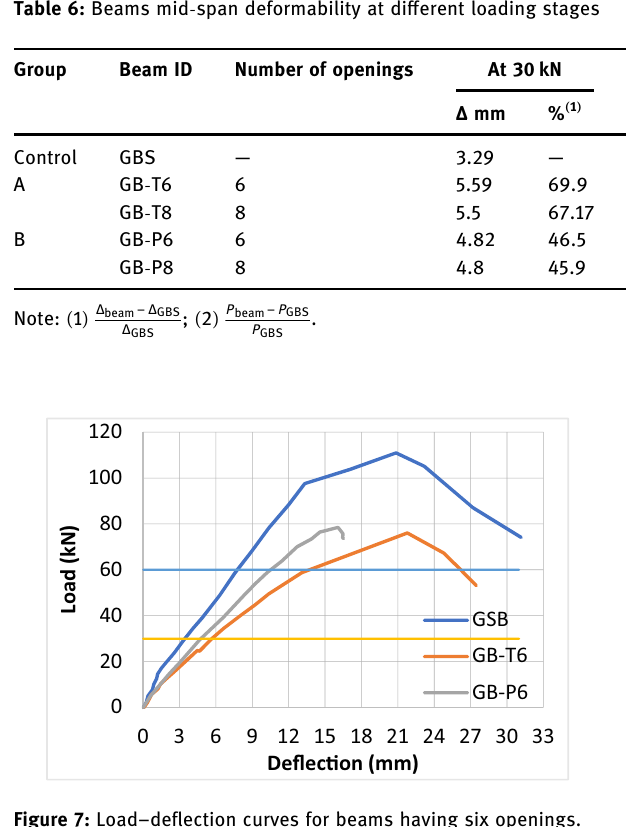
Figure 7: Load – de fl ection curves for beams having six openings.